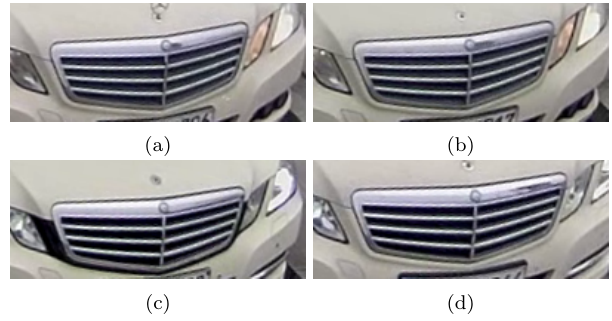
Figure 5: Face area of four identical Mercedes E-Class 212. The field of view was well confined and cut.